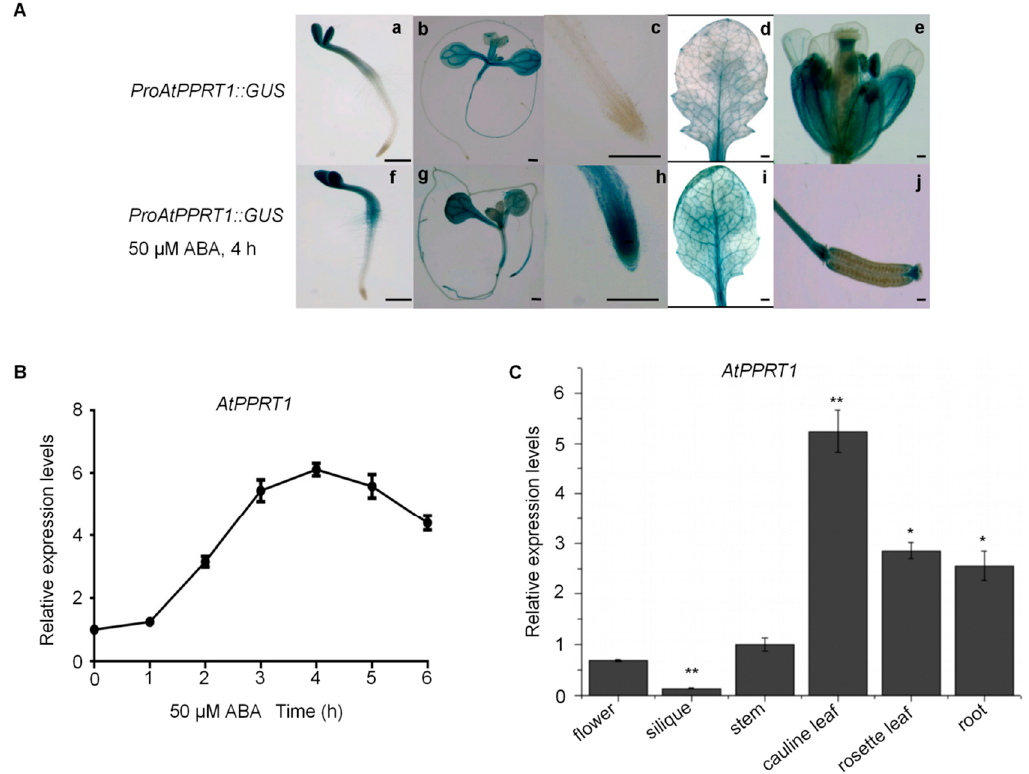
Figure 3. Tissue-specific expression of AtPPRT1 and its ABA-induced expression levels. ( A ) Expression pattern of AtPPRT1 in ProAtPPRT1::GUS transgenic Arabidopsis before ( a–e , j ) and after ( f–i ) ABA treatment. Tissues of AtProPPRT1::GUS transgenic plants including 3-day-old seedlings ( a ), 7-day-old seedlings ( b ), and its root tip of the main root ( c ), rosette leaf of a 3-week-old plant ( d ), flower ( e ) and silique ( j ) of a 40-day-old plant. The plant samples of ( f–i ) shared the same materials with those of ( a–d ), respectively, despite the former ones processed by 50 μ M ABA for 4 h. Bars = 500 μ m; ( B ) qRT-PCR analysis of AtPPRT1 expression levels induced by ABA; ( C ) qRT-PCR analysis of AtPPRT1 expression in different tissues of 40-day-old seedlings. The values are the average of three individual biological replications. Error bars represent ± SD ( n = 3, * p < 0.05 and ** p < 0.01, t -test).